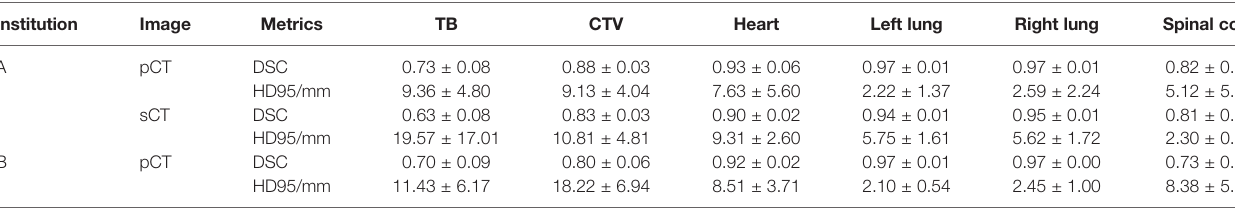
TABLE 3 | Quantitative results (Mean ± SD) of automatic delineation performance in multiple institutions. Institution